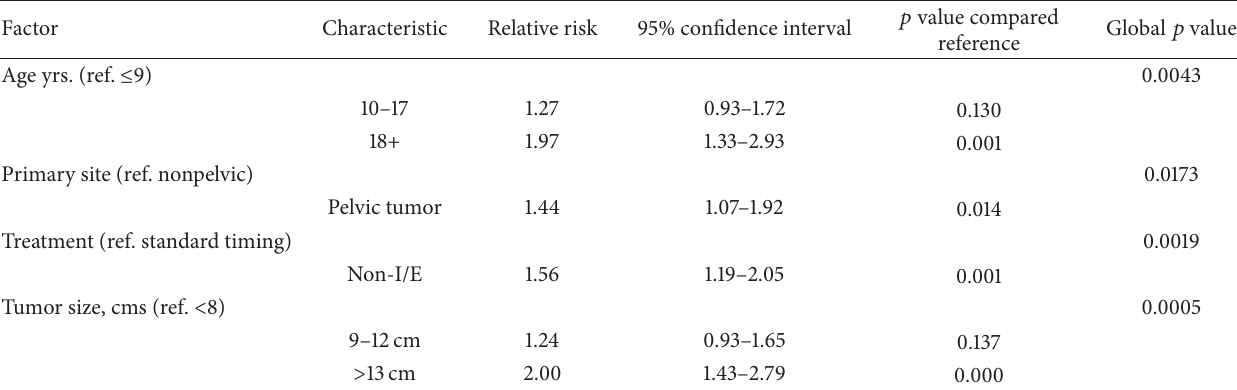
Table 5: Estimated risk coefficients for patients treated in INT-0091 and INT-0154 (P9354) [excluding patients in AEWS0031] ( 𝑁 =